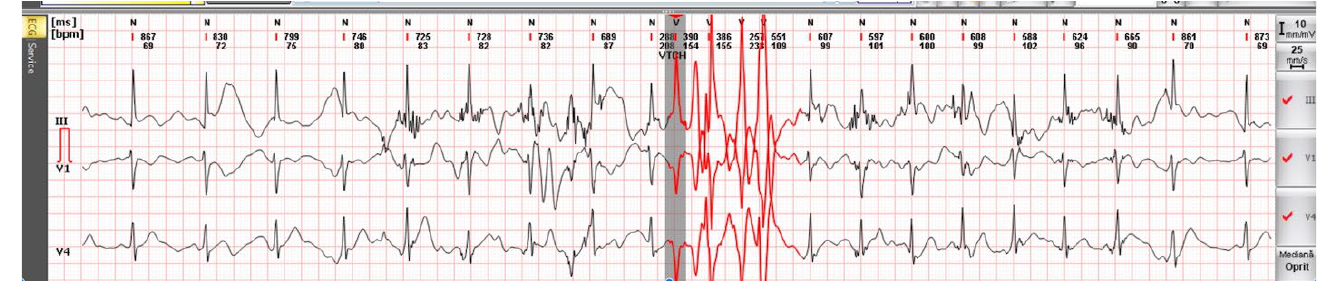
Figure 8. Case 2—ECG Holter monitoring capture showing ventricular tachycardia (VTCH— ventricular tachycardia).